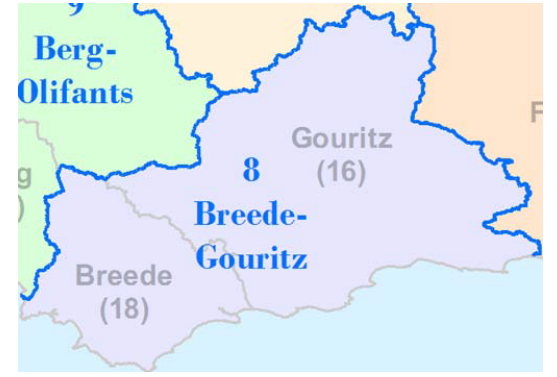
Fig. 2. Map showing the Breede-Gouritz Water Management Area (WMA) after amalgamation of the Breede and Gouritz WMAs. Source: DWAF (2004 c